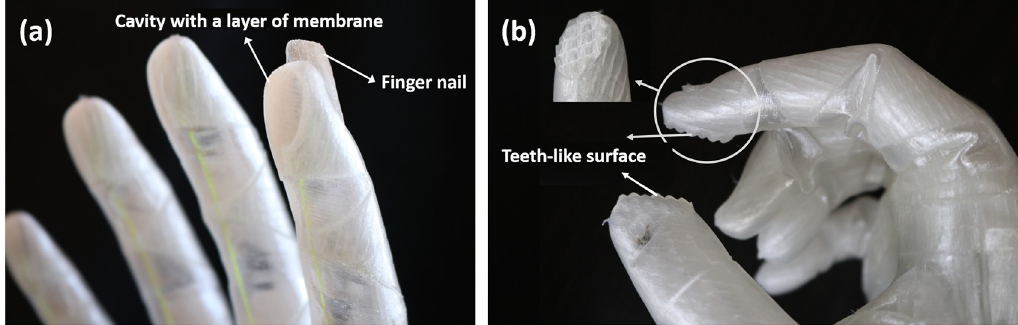
Fig 4. Fingertip build-in features: (a) 3D printed finger nail for collecting thin objects such as coins and a cavity in the fingertip for increasing the contact surface area in pinch grasp; (b) 3D printed teeth-like surface on index fingertip and lateral side of the thumb for stable pinch